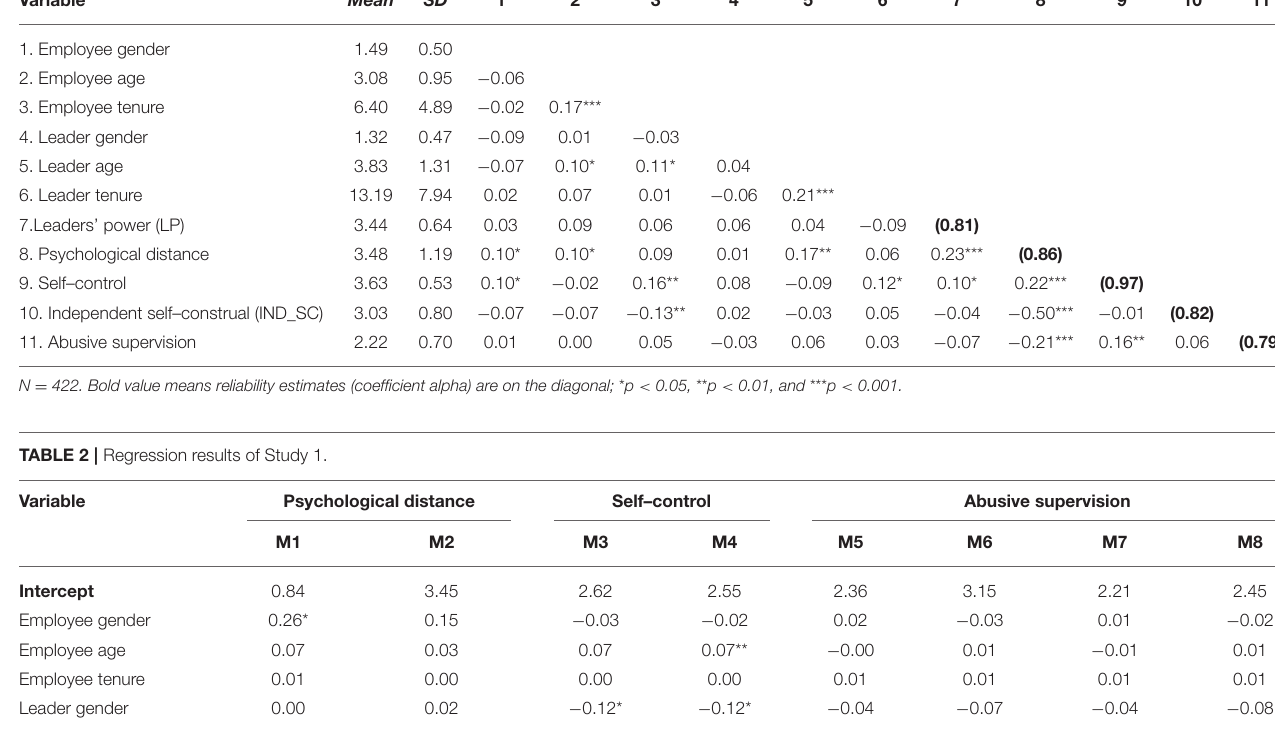
TABLE 1 | Descriptive statistics and correlations of Study 1. Variable